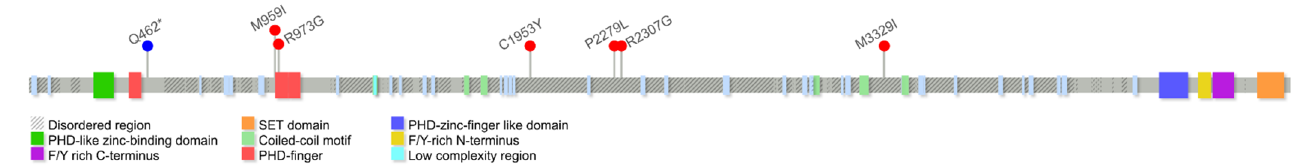
Figure 5. Distribution of the KMT2C mutations detected in this study, along the gene.